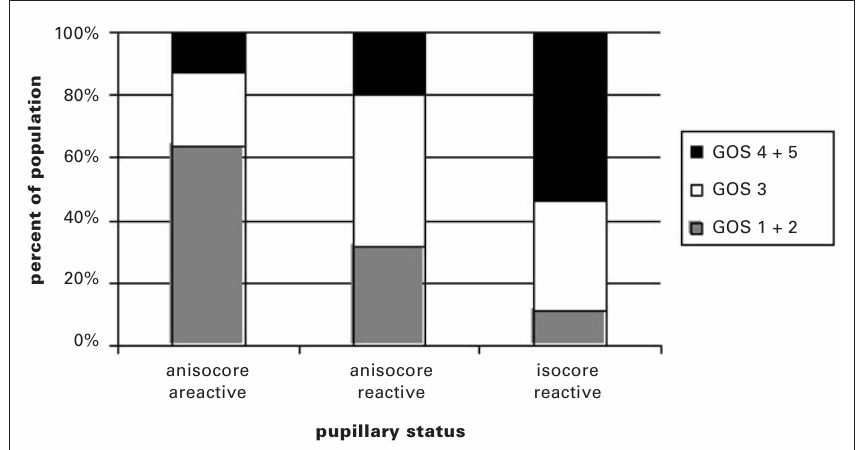
Documenting out- come with respect to initial pupillary status classified as aniso- core areactive, aniso- core reactive and iso- core reactive. Aniso- core areactive pupil- lary status associated with a higher percentage of un- favourable outcome as opposed to iso- core reactive status showing a higher per- centage of favourable outcome.